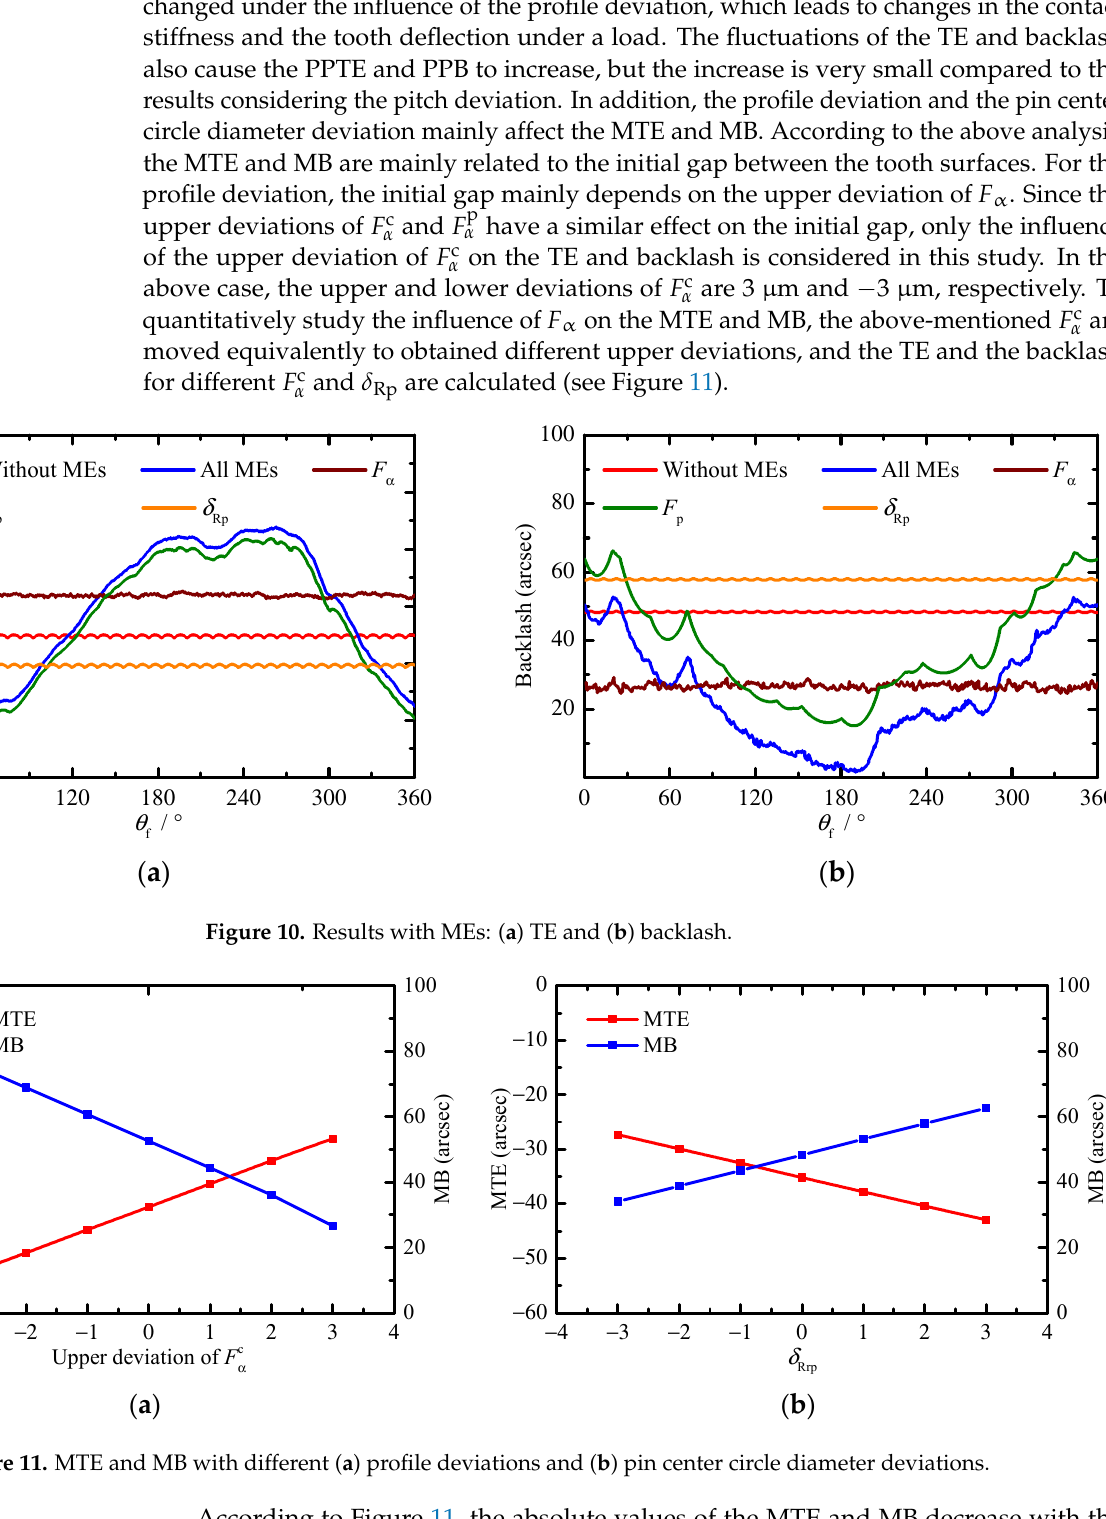
Figure 11. MTE and MB with different ( a ) profile deviations and ( b ) pin center circle diameter deviations.